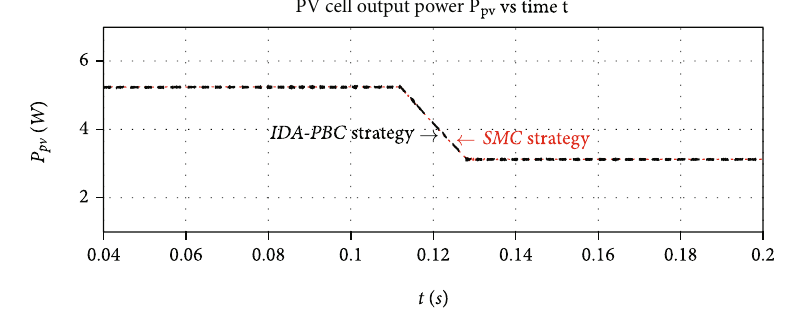
Figure 4: PV cell output power response to given input power radiation levels with IDA-PBC and SMC strategies.